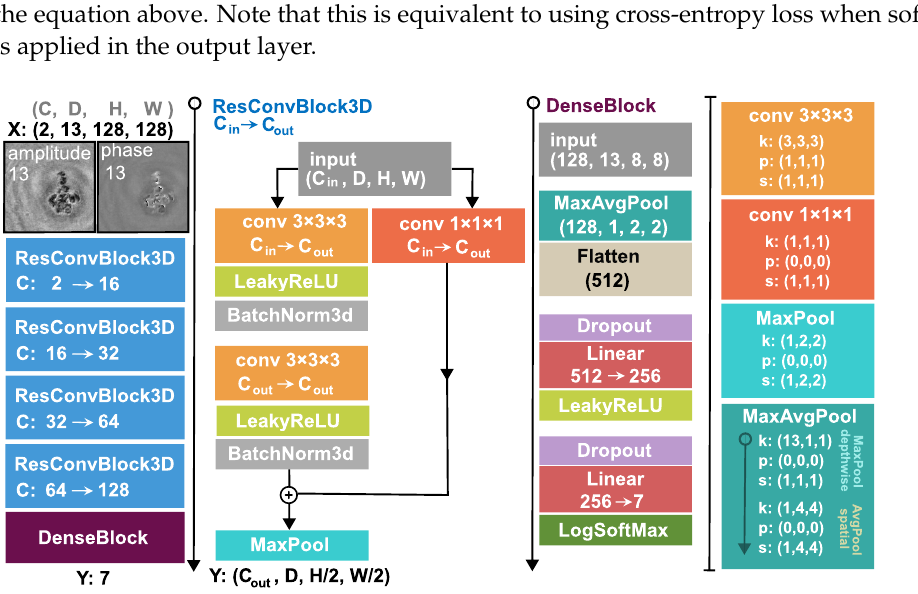
Figure 2. Illustration of the 3D-model architecture. The input of the 3D network is the amplitude and phase image (C = 2) of the initial hologram together with its 6 steps forward and 6 steps backward propagated forms (D = 13). The output of the network is the class log probabilities. The symbol k denotes the 3 dimensional kernel size (D,H,W), p the padding, and s the